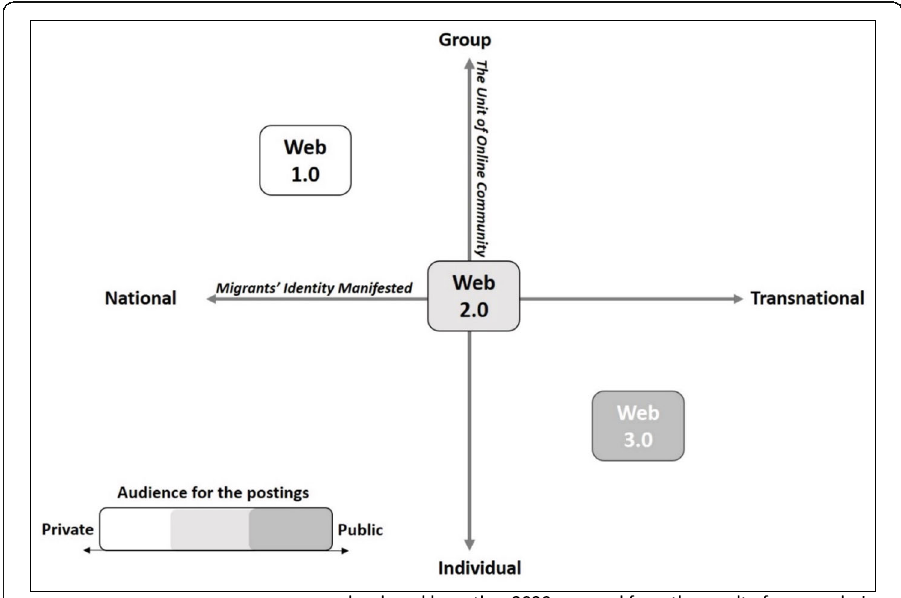
Fig. 2 Relation among transnational identity, the unit of community, and type of